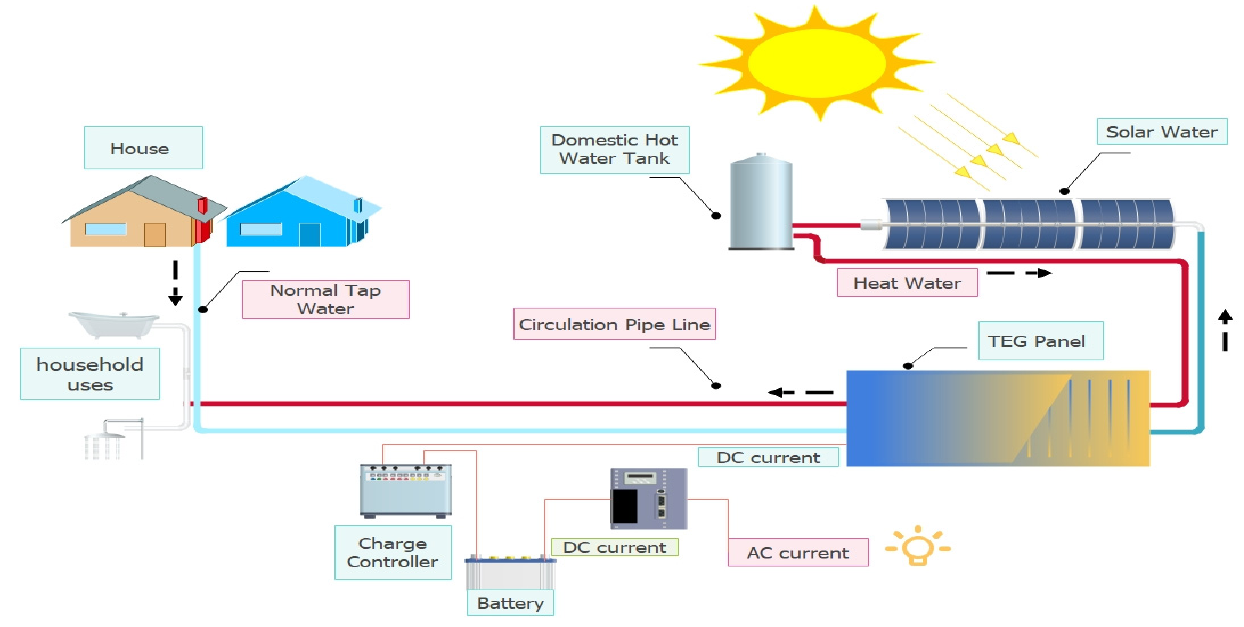
Figure 2. A sustainable energy system using TEG panels and solar water heaters.